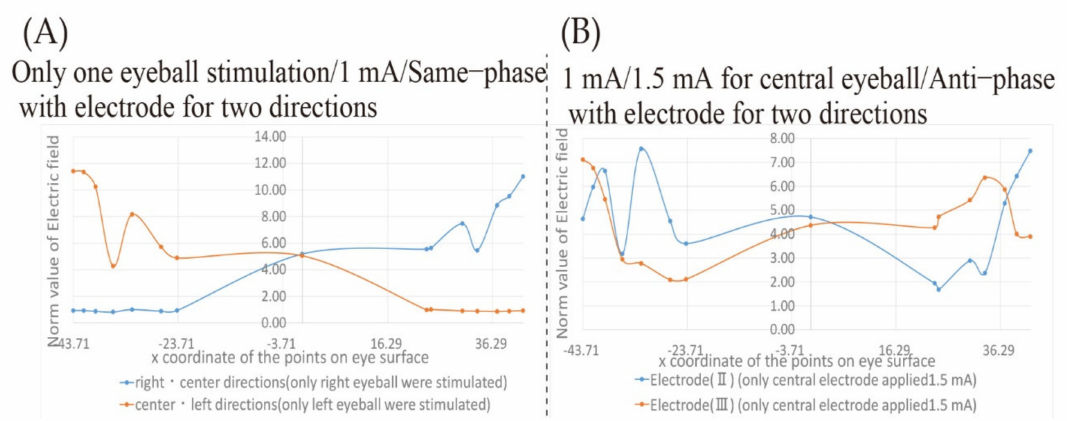
Figure 11. The transition of the electric field value on the eye surface with the electrode placement that presents the phosphene in two directions of visual field; ( A ) norm value of electric field in 1 mA and same-phase stimulus with electrode to present phosphene in two directions that stimulate only one eyeball; ( B ) norm value of electric field in anti-phase stimulus with electrode to present phosphene in two directions that stimulate with 1 mA for the nasal eyeball and 1.5 mA for the central